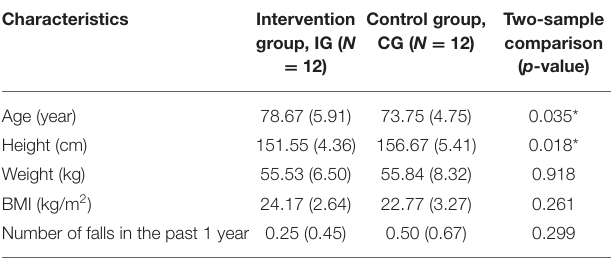
TABLE 1 | Demographic characteristics (mean, standard deviation in bracket) of the intervention group and the control group.